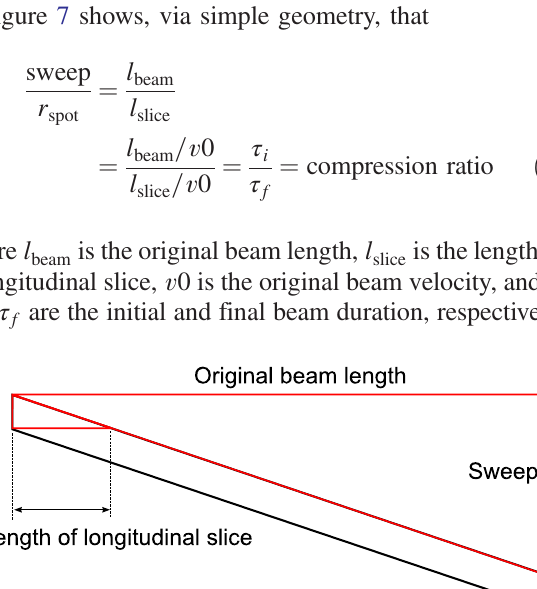
FIG. 5. Side view in real space as a beam with finite spot size approaches the wedge. Outlying beam ions whose y positions are above the centroid of the beam tail or below the centroid of the beam head experience the same energy loss as the respective centroid.